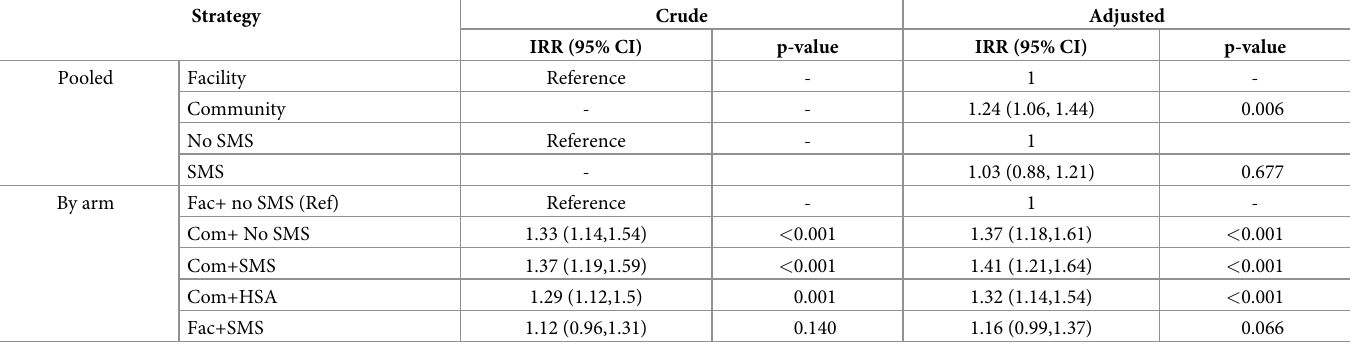
Table 4. Poisson regression model excluding PMC 1 with an interaction term in factorial design analysis for adherence between a) community compared to facility and b) SMS compared to no